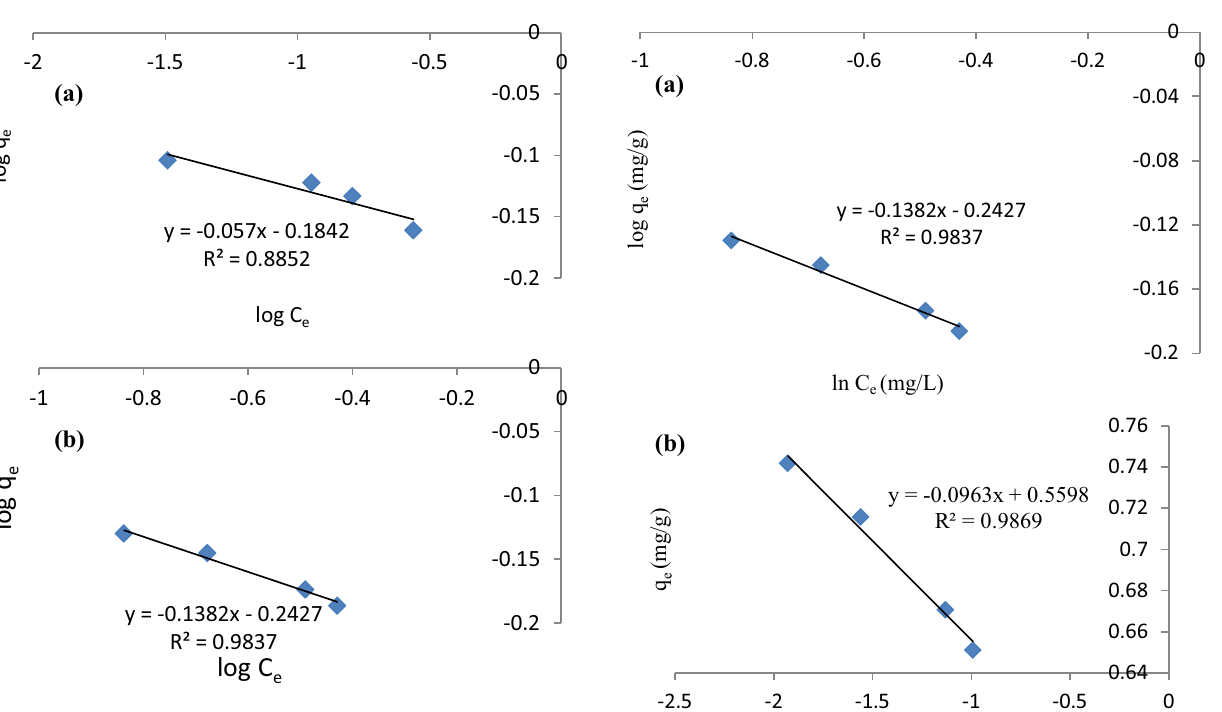
Fig. 2 a Freundlich Isotherm for effect of initial fluoride ion concen- tration on defluoridation (Acid treated Moringa oleifera leaves pow- der). b Freundlich Isotherm for effect of initial fluoride ion concentra- tion on defluoridation (Alkali treated Moringa oleifera leaves powder)